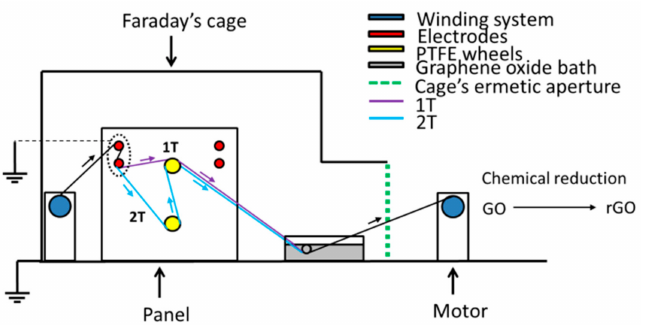
Figure 2. Schematic representation of the triboelectrification deposition process of graphene oxide on glass